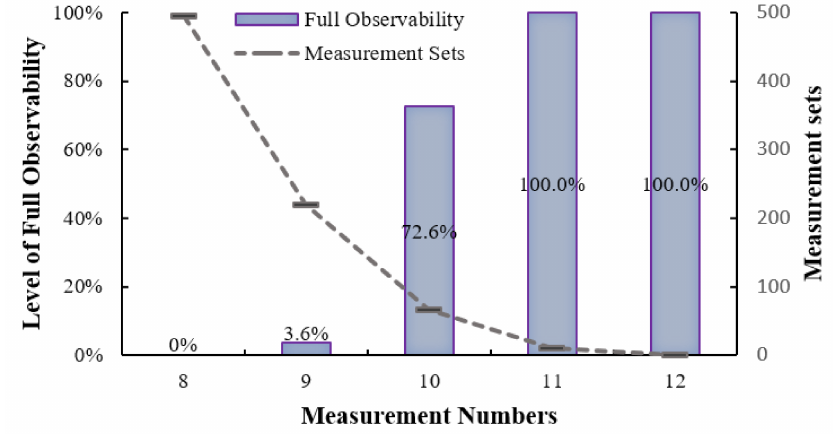
Figure 4. Full observability of the system based on the various measurement